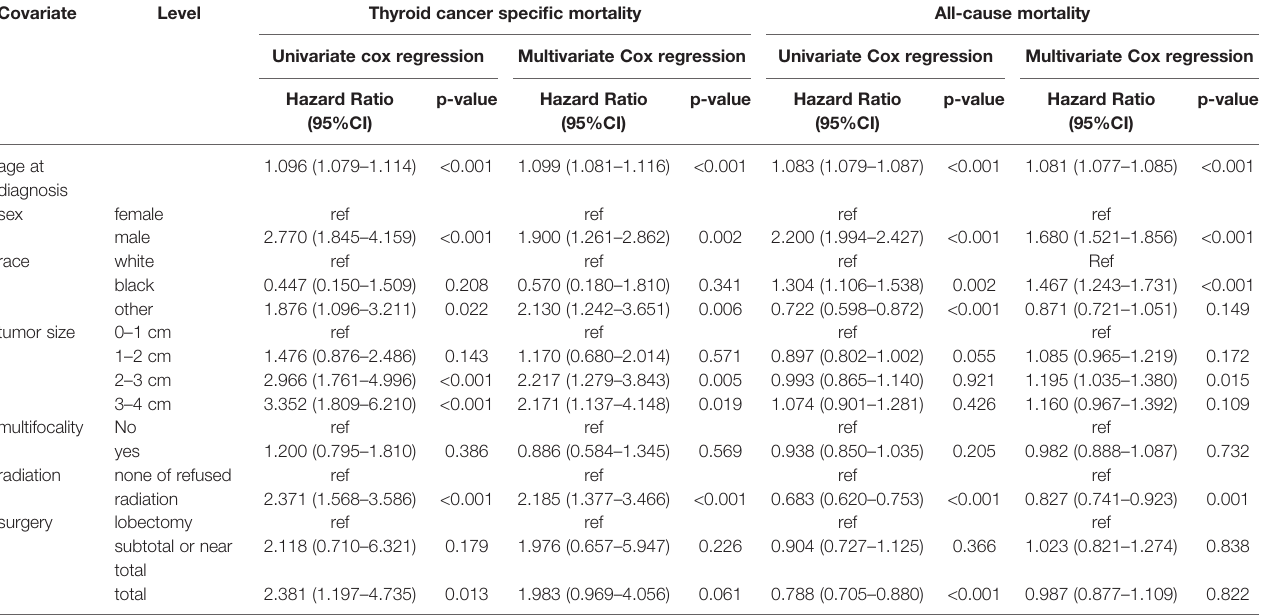
TABLE 2 | Risk factors for survival: Outcome of thyroid cancer speci fi c mortality and all-cause mortality. Covariate